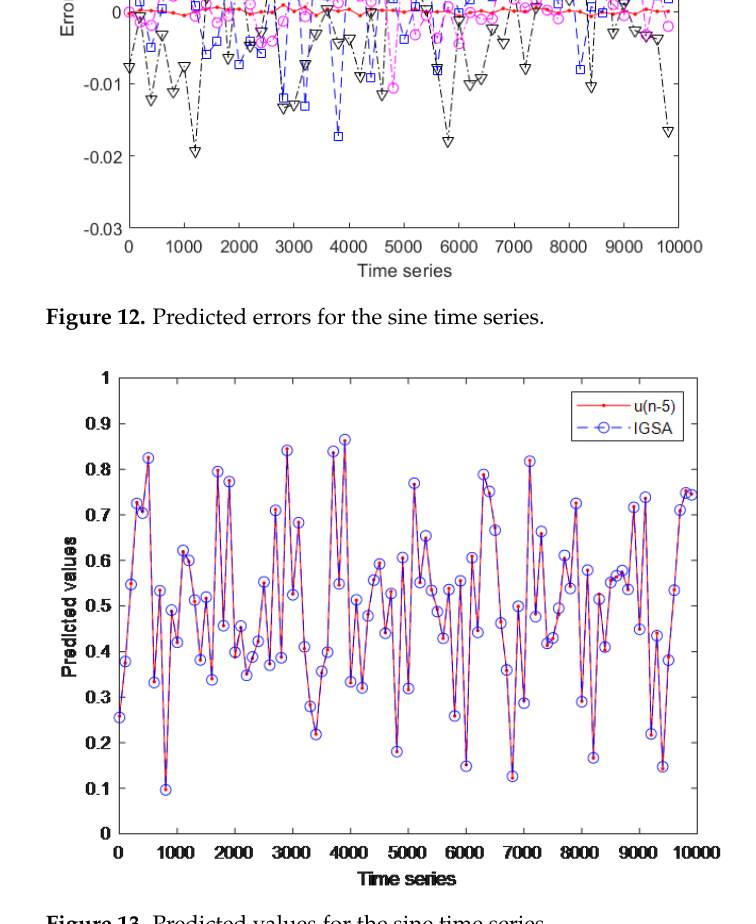
Figure 13. Predicted values for the sine time